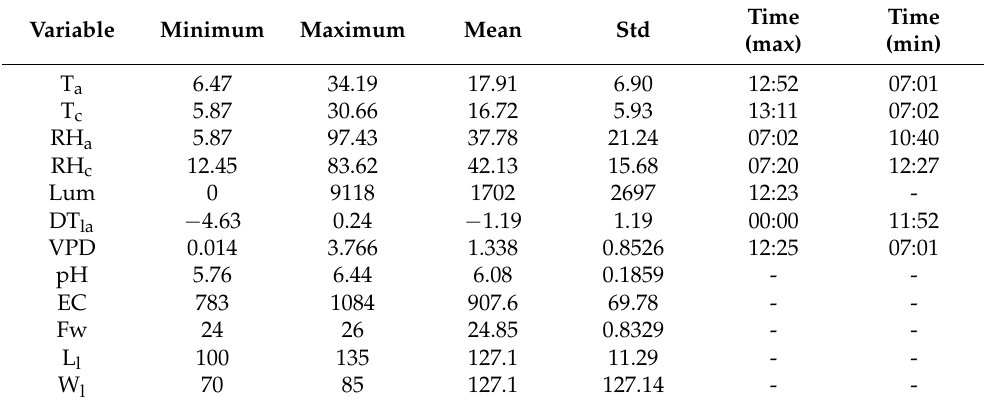
Table 4. Analysis of main variables in the proposed intelligent monitoring system.